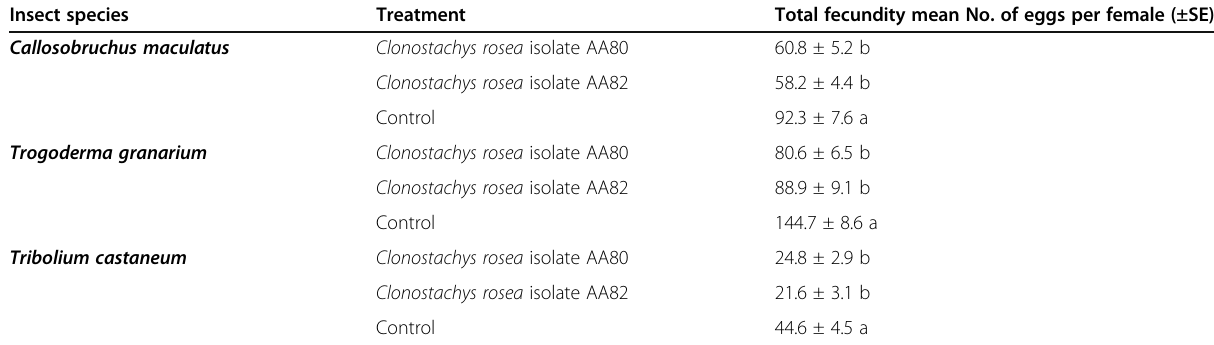
Table 4 Effect of fungal infection on the mean numbers of eggs produced per adult female of either Callosobruchus maculatus , Trogoderma granarium or Tribolium castaneum compared to the control Insect